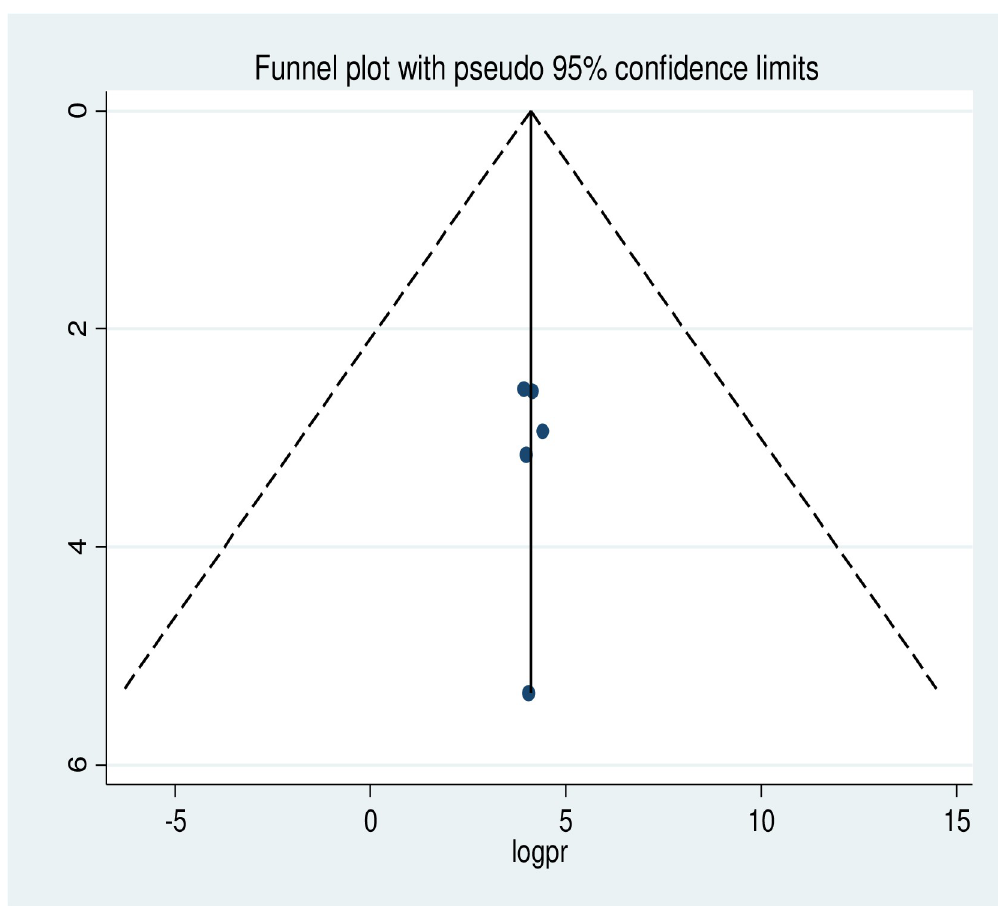
Fig 6. Funnel plot showing symmetrical distribution of studies indicating absence of publication bias. The Y-axis is the standard error and the X-axis is the study result or effect size. The dotted diagonal lie of the funnel is the 95% confidence interval and the vertical. The vertical line is the line of no-effect and dots are included studies reporting attitude of kangaroo mother care.